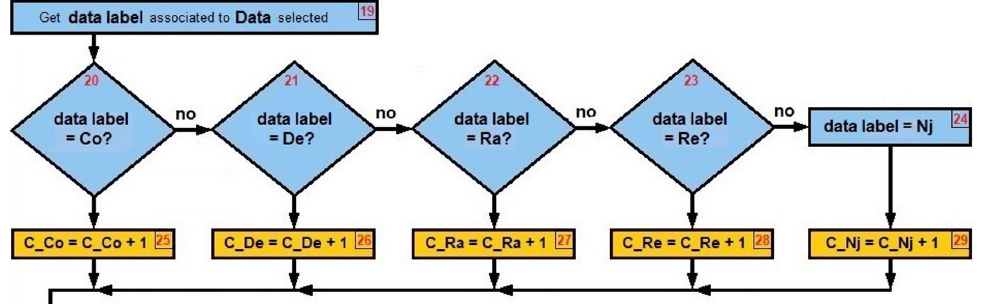
Figure 19. Data label